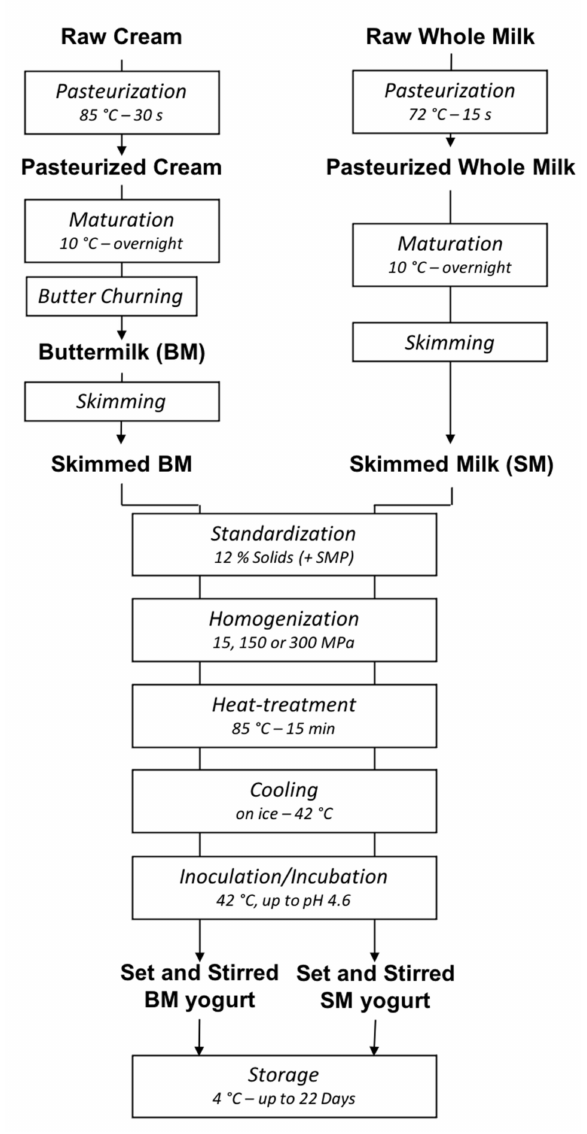
Figure 1. Experimental design of the production of set and stirred yogurts from buttermilk (BM) and skimmed milk (SM) treated by ultra-high-pressure homogenization